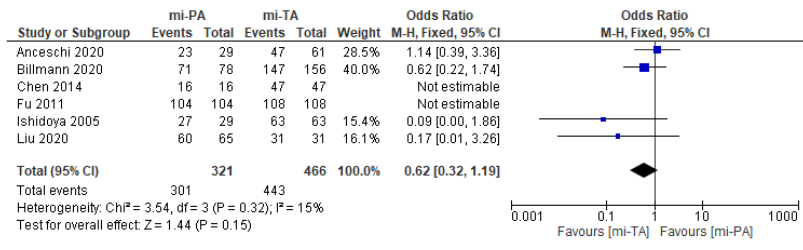
( h ) postoperative mean potassium serum levels, ( i ) postoperative persistent hypokalemia, ( j )